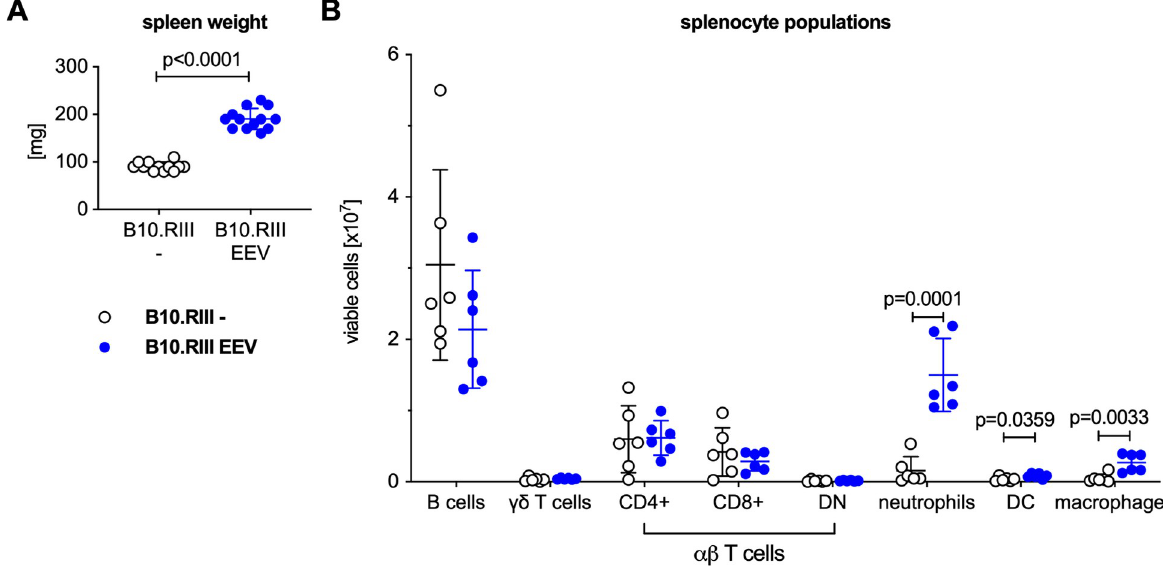
Fig 3. Systemic overexpression of IL-23 results in expansion of myeloid cells in the spleen. (A) Spleen weight of the mice from the experiment in Fig 1. (B) For a subset of animals, single cell suspensions were prepared from the spleen and analyzed by flow cytometry, n = 5 mice/group. P values were determined by unpaired